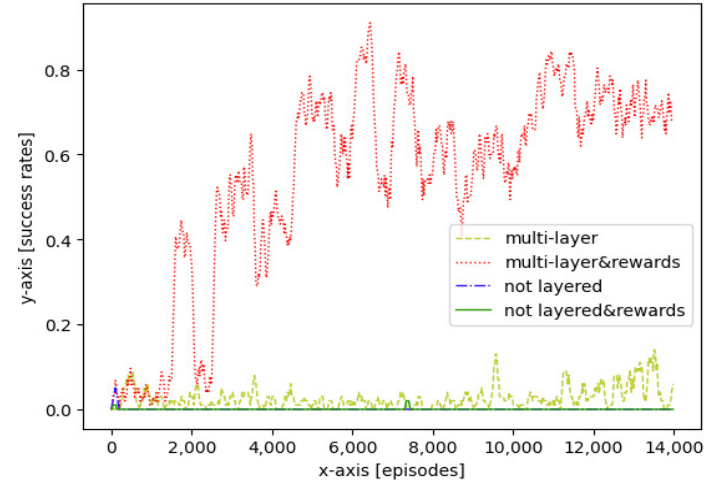
Figure 12. Training success rates, considering arrival time: multi layer approach without reward shaping; multi layer approach with reward shaping; not layered approach without reward shaping and not layered approach with reward shaping.